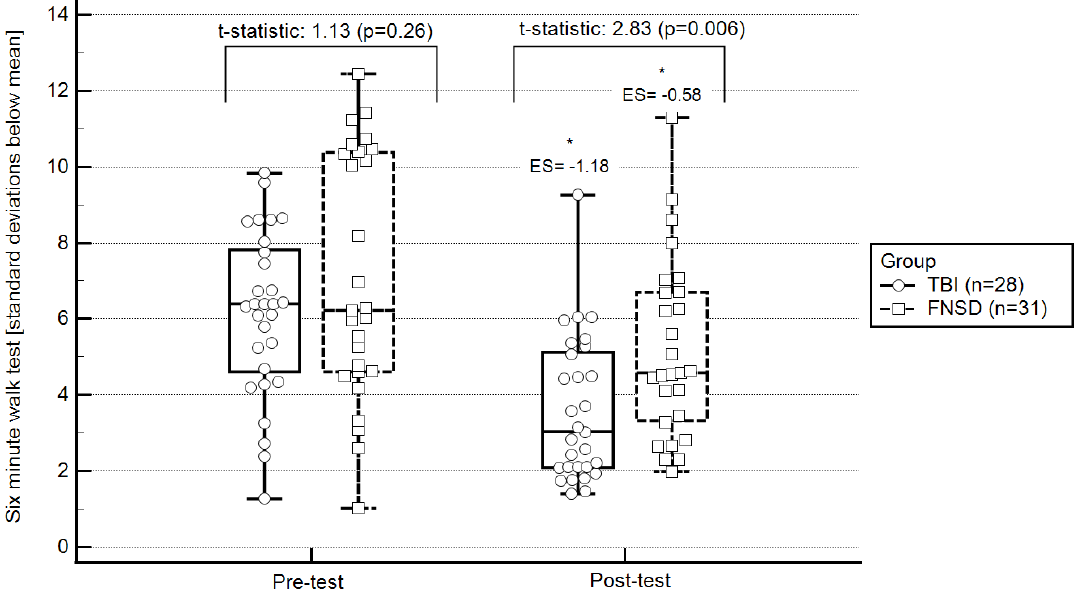
Figure 1. Pre- and post-test walking ability relative to the norm: within- and between-group differences. Notes: * statistically significant within-group changes ( p < 0.05; 2-tailed); ES, effect size of within-group changes from pre- to post-test (ES is based on a single pooled standard deviation (Cohen’s d = mean ∆/standard deviation average from two means ) and was corrected for dependence between means). FNSD, functional neurological symptoms disorder; TBI, traumatic brain injury; central box,- values from the lower to upper quartile (25 to 75 percentile); vertical line, minimum to the maximum values; middle line, median.